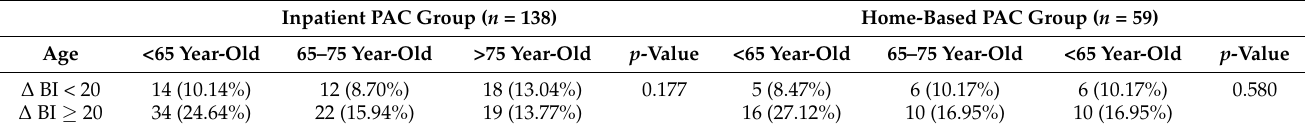
Table 3. Comparison of age and improvements of the Barthel index in inpatient and home-based PAC